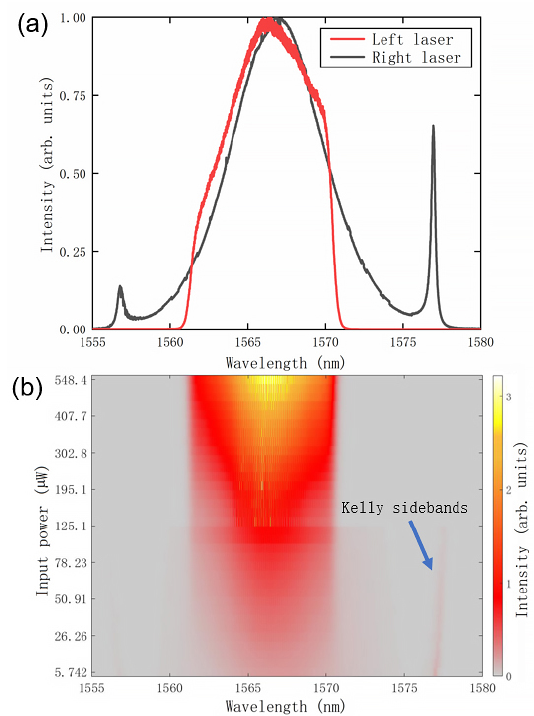
Figure 2. ( a ) The spectrum of the left laser (red) and the spectrum of the right laser when no signal is input to it—self-excitation mode (black); ( b ) the spectra evolution of the right laser when the input signal from the left laser is varied.